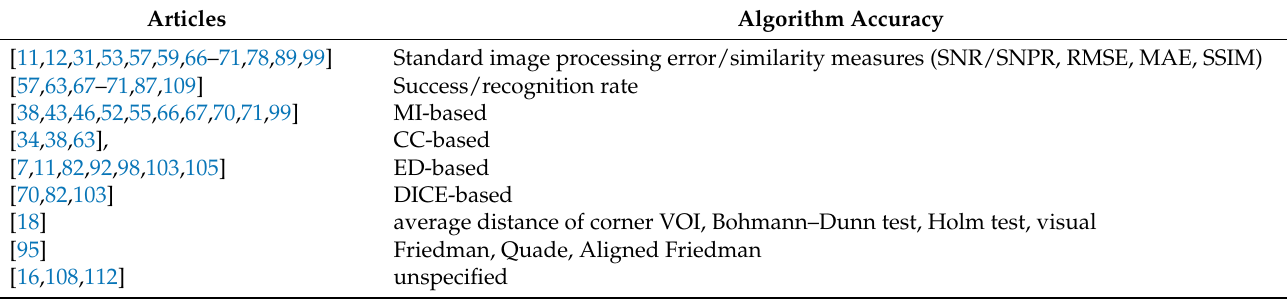
Table 5. Performance indicators used in the reviewed articles.